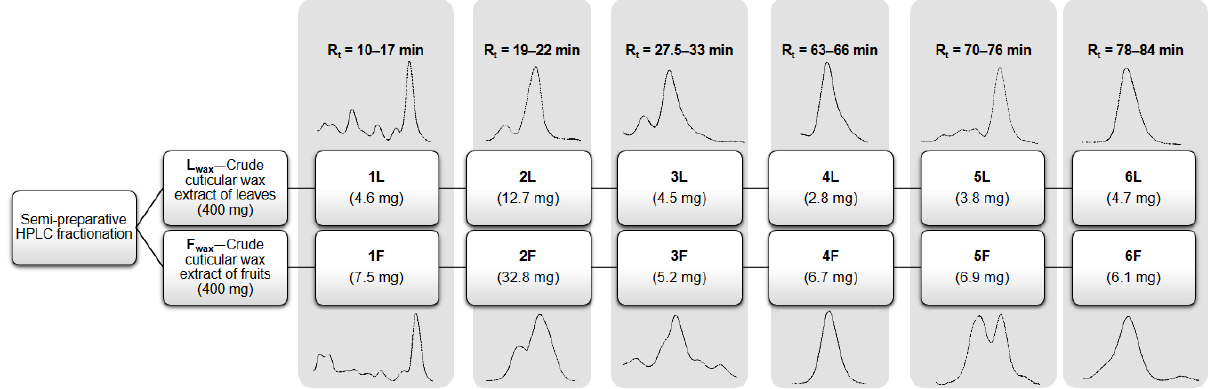
Figure 1. Scheme for the semi-preparative HPLC fractionation of the crude cuticular wax lingonberry extracts.